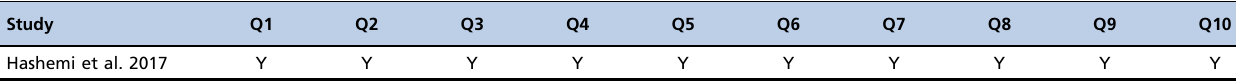
Table 4 - Critical appraisal results for included studies using the Joanna Briggs Institute for checking case control